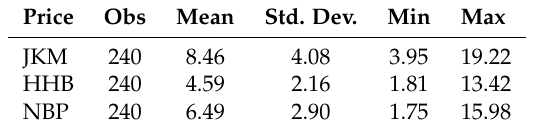
Table 1. Basic statistics (monthly between January 2000 and December 2019 in $/mmbtu). Price Obs Mean Std.